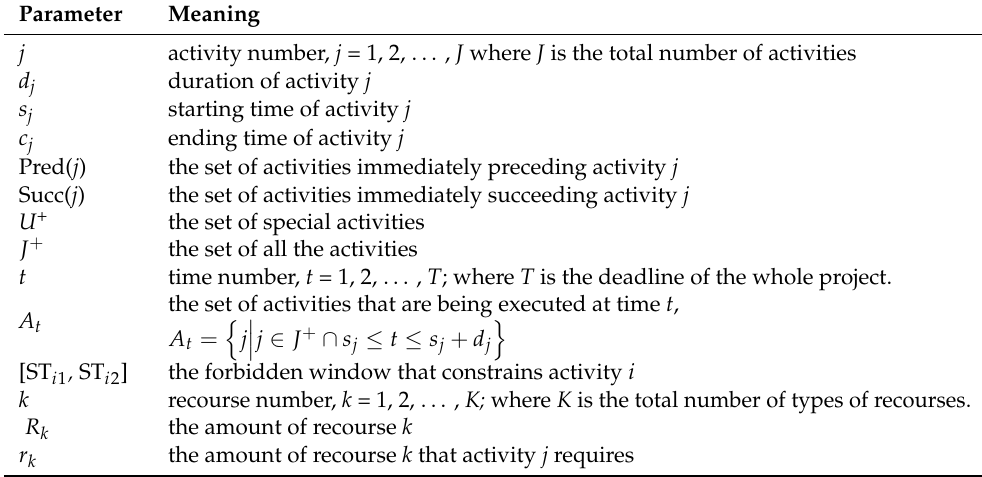
Table 1. Parameters used in the proposed model.